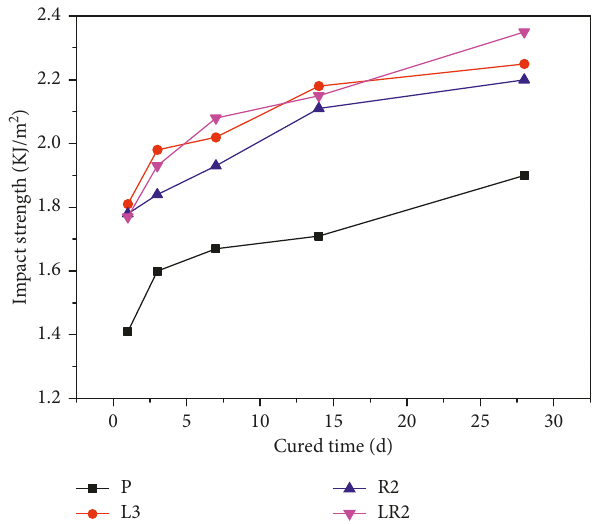
Figure 11: Impact strength of cement slurry with curing time.